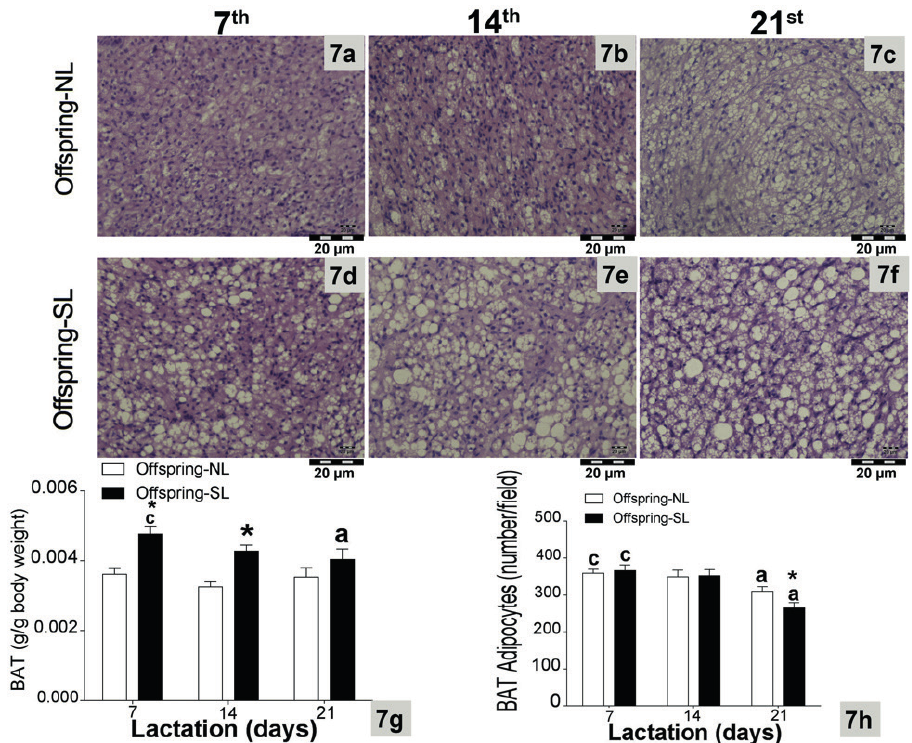
Figure 7 - Histological analysis of the BAT from SL-offspring and NL-offspring in different lactational phases. The values are expressed as mean ± Standard Error of the Mean (n= 9-12 animals/ group). The symbol above bars indicates a significant difference (p<0.05) between the groups (Two- way ANOVA with uncorrected Fisher´s LDS: * SL versus NL; a 7 th day of lactation; b 14 th day of lactation and c 21 st day of